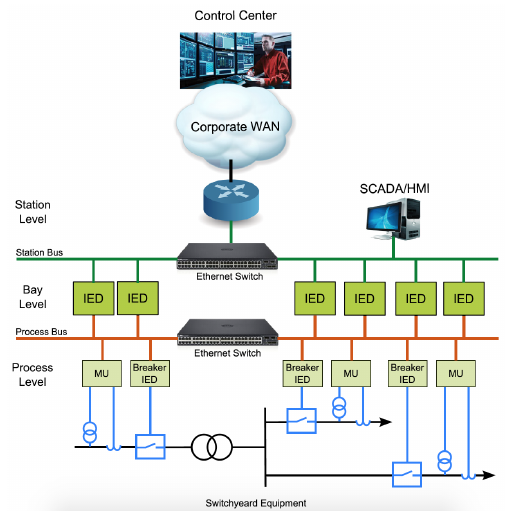
Figure 1. IEC 61850 substation logical distribution